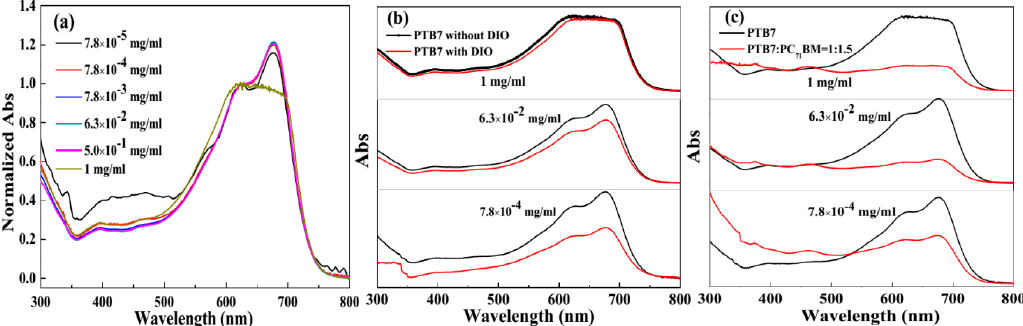
Figure 5. Steady-state absorption spectra of PTB7 solution and mixed PTB7:PC 71 BM solution at varied concentration conditions. ( a – c ) represent the effects of concentration, DIO additive and PC 71 BM on the steady-state absorption spectra of PTB7 solutions.